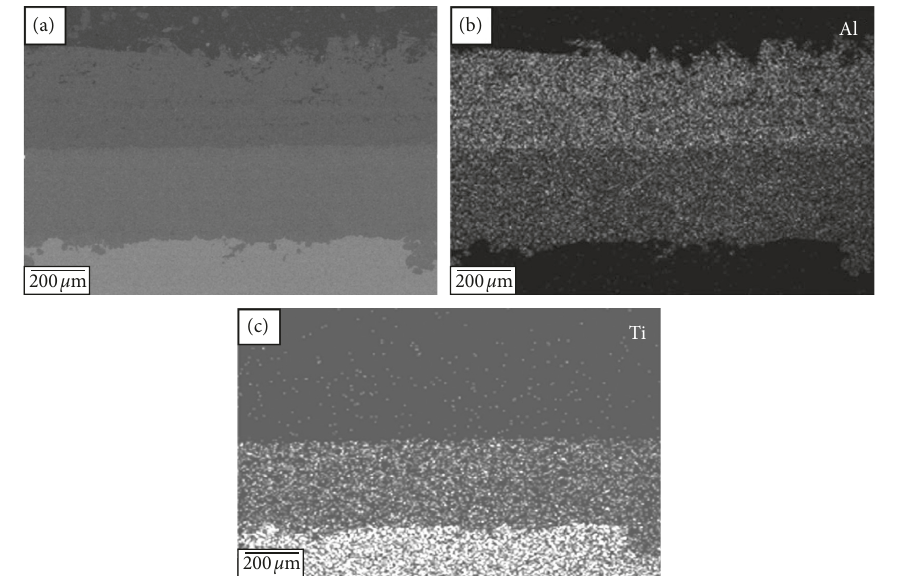
Figure 2: (a) Cross-sectional BSD image of Al coating after testing for 5 hours at 973K and the distributions of (b) Al and (c) Ti.